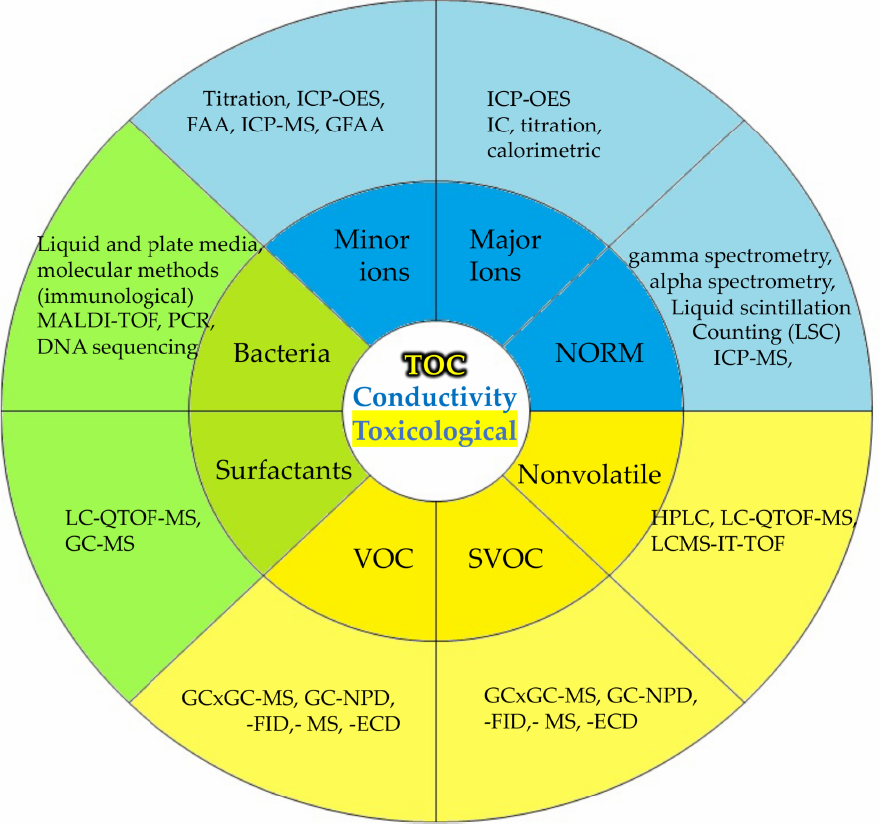
Figure 1. Schematic of the different classes of water quality constituents found in FP and the respective analytical techniques that are used for analyte detection and quantitation. The text for the two surrogate measurements TOC and conductivity listed in the center are color coded for the constituent classes of which they are representative. Toxicological analyses can be used in conjunction with TOC/conductivity measurements to cover potential signal from NORM and/or influence from volatile and semi-volatile compounds that would be detected by untargeted analyses. Adjusted with expressed written consent from Liden et al